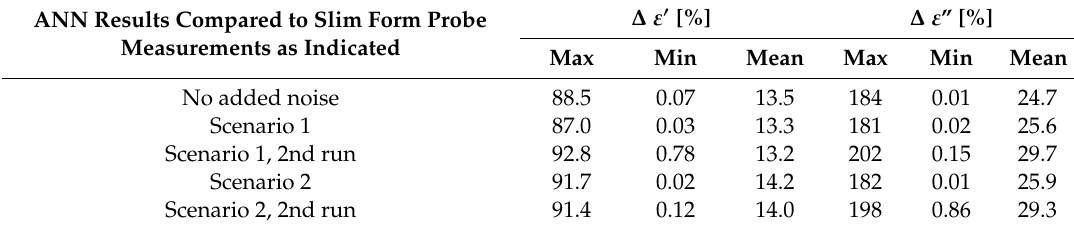
Table 6. Maximum, minimum and average differences between measured and predicted permittivity at 2.45 GHz using raw input data (no added noise); Scenario 1 (noise added to training and validation data); Scenario 2 (noise added to training, validation and testing data).